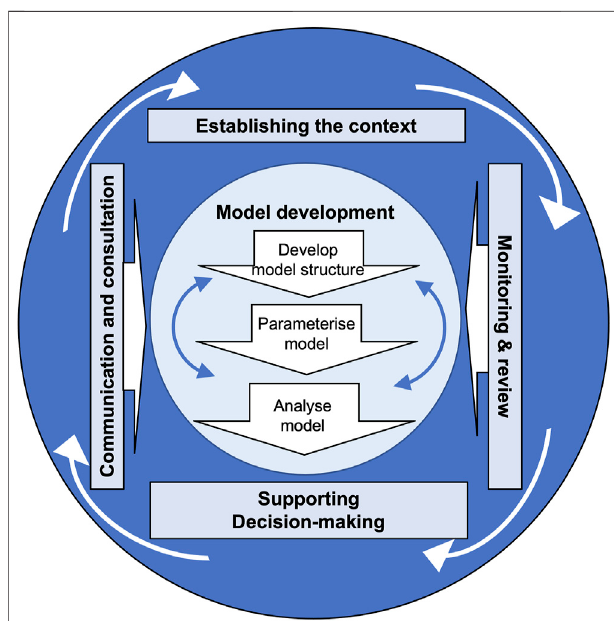
FIGURE 2 | The process of the BN model development to support decision-making based on the ISO risk management process (International Organization for Standardization (ISO, 2018)). It is embedded in Communication and Consultation with the stakeholders and Monitoring and